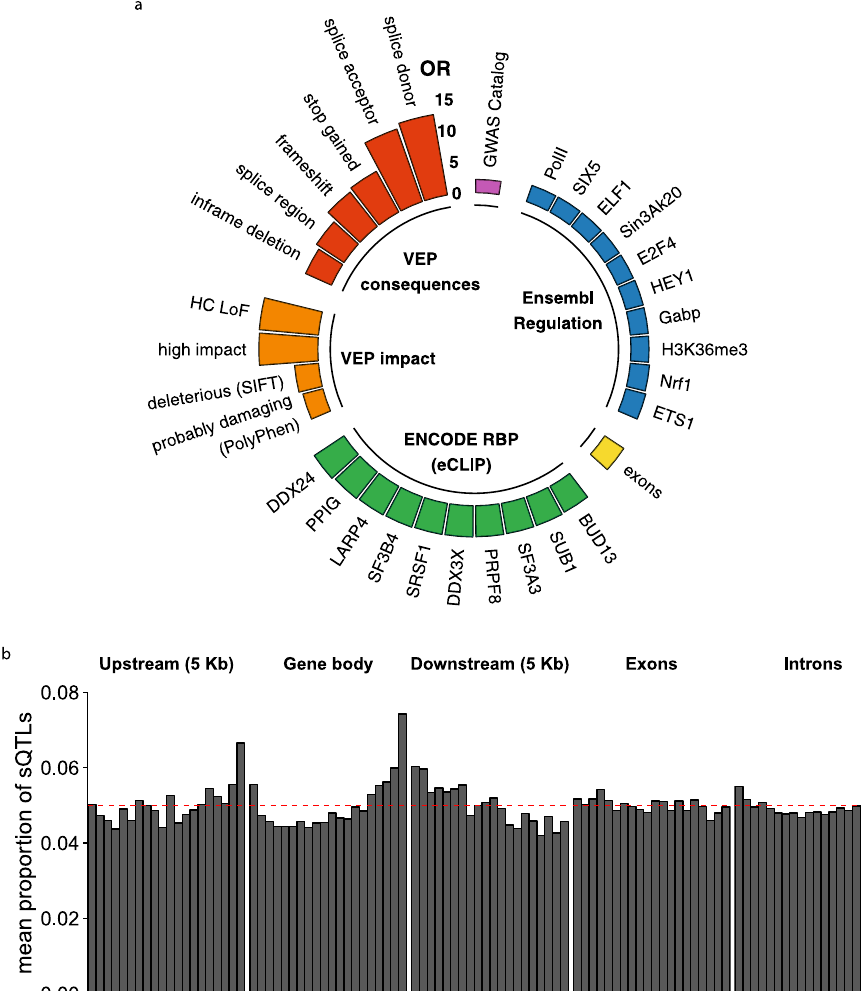
Fig. 3 Functional enrichment and distribution of sQTLs. a Top enrichments of sQTLs in functional annotations. The height of the bars represents the odds ratio (OR) of the observed number of sQTLs to the expected number of variants that are not sQTLs overlapping a given annotation (see Methods): Variant Effect Predictor (VEP) categories (red) and impact (orange), ENCODE RBP eCLIP peaks (green), exons of GENCODE v19 protein coding and lincRNA genes (yellow), Ensembl Regulatory Build elements (blue) and GWAS Catalog hits (purple). All these enrichments are signi fi cant at FDR < 0.05 and have OR con fi dence intervals not overlapping the range [1/1.50, 1.50]. b Distribution of the mean proportion of sQTLs along the gene bodies of sGenes, their upstream and downstream regions, introns and exons. The red dashed line represents the expected distribution under a uniform model (see Methods). Source data for both a and b are provided as a Source Data fi